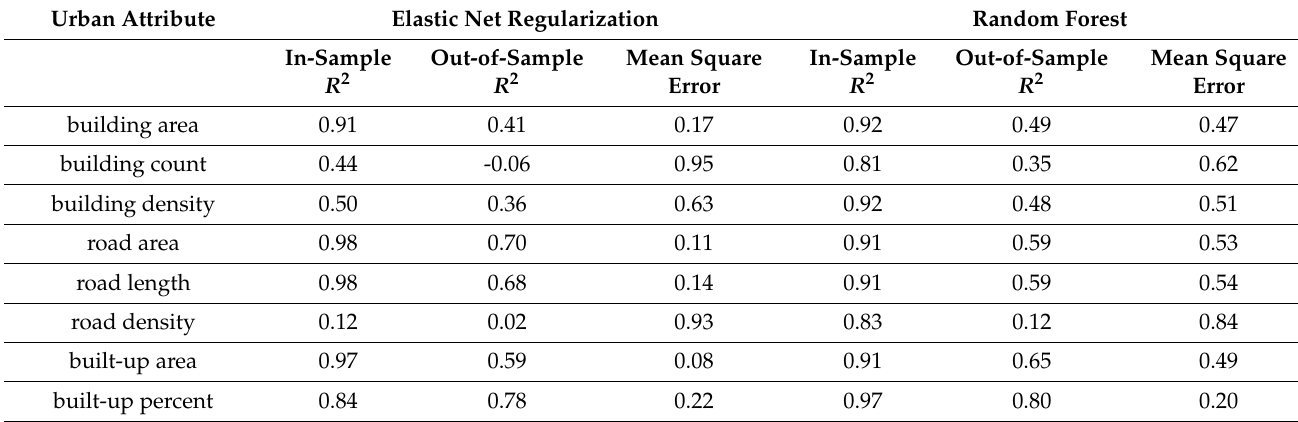
Table 9. R 2 and mean square error values for urban attributes using elastic net regularization and random forest models with Sentinel-2 imagery for Accra (314 Enumeration Areas).